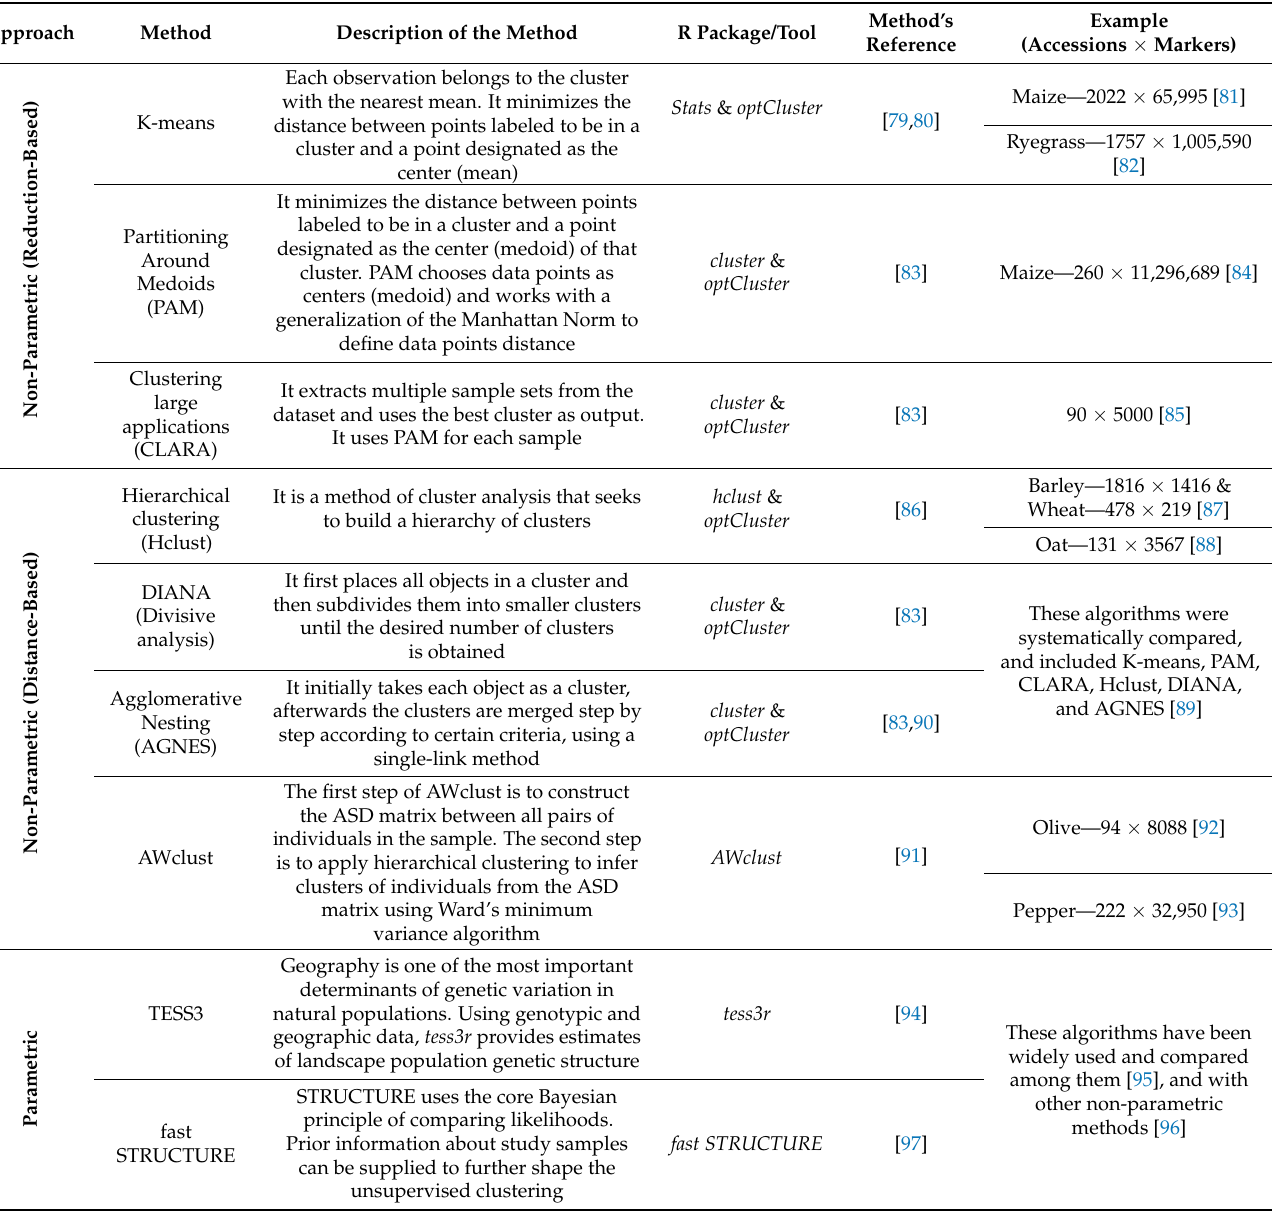
Table 1. Non-parametric and parametric classification approaches that can assist clustering efforts to differentiate between abiotic stress tolerant and susceptible germplasm accessions. Habitat types and local adaptation to heat and drought stresses can be inferred using climate variables and physiological indices from each accession’s geo-referencing (Figure 1b) because crop wild relatives and landraces have occupied local niches (e.g., arid vs. wet regions) long enough as to be shaped by natural selection. Predicted thermal tolerance and water use efficiency, together with other data types (Figure 1e,f), can then be merged (Figure 1g) in order to identify and unlock novel sources of heat and drought tolerance. The trained classification may also speed-up the utilization of these tolerant variants by genomic-assisted breeding techniques (Figure 1i). ML approaches (Table 2) are also capable of including further data types for more cohesive multi-dimensional predictions (e.g., Figure